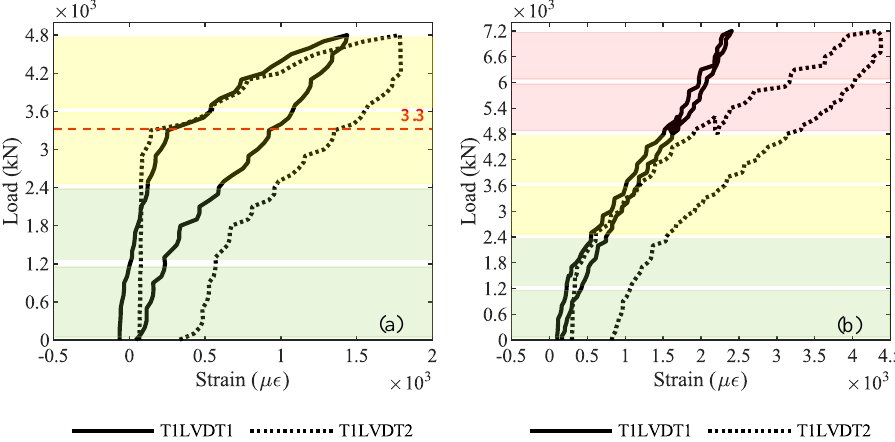
Figure 10. Longitudinal strain at the bottom of the middle cross section of girder T1: ( a ) loading phase P3; ( b ) loading phase P4. The red dashed line represents the first-crack load identified by crack-opening sensors.